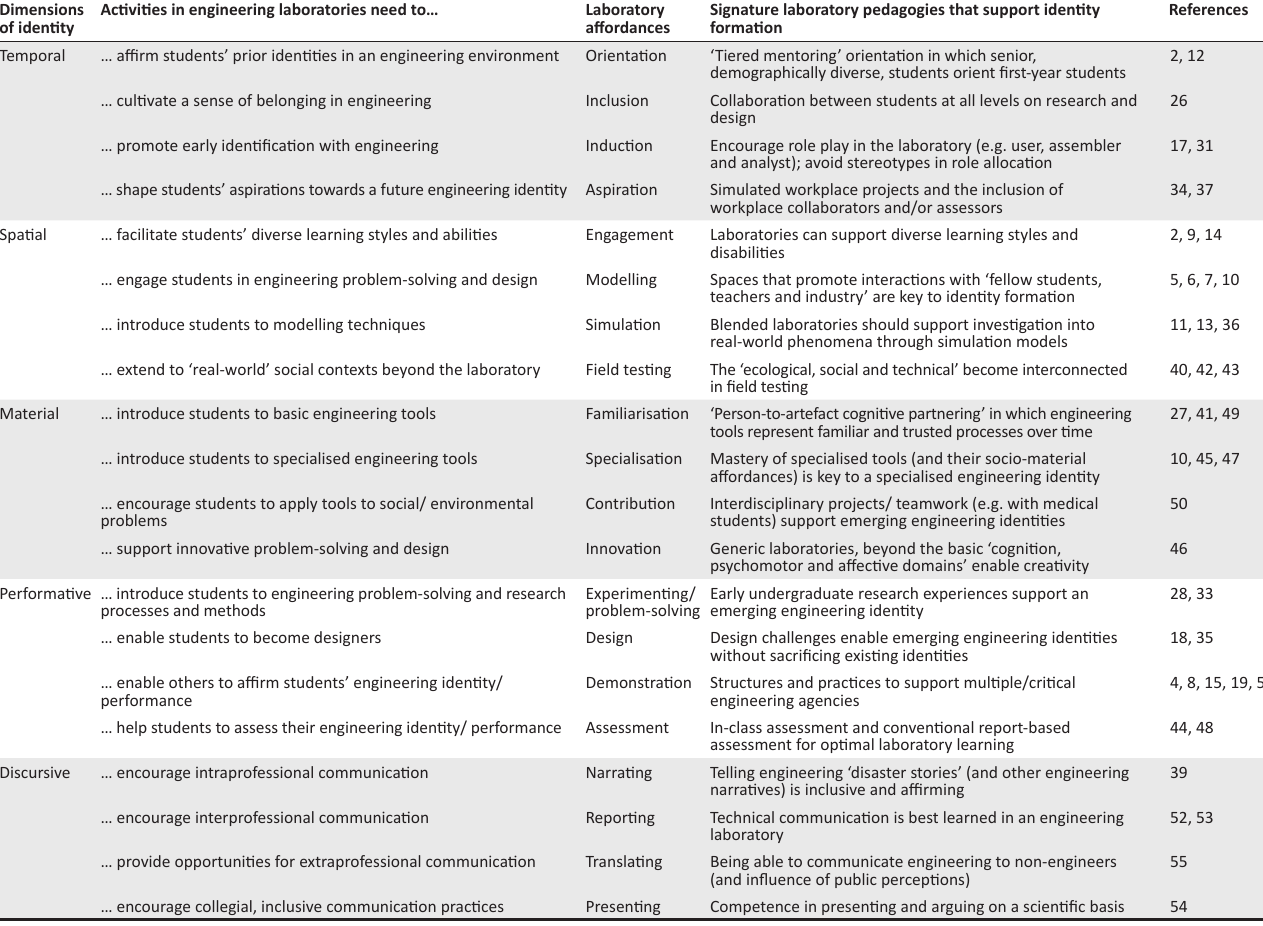
TABLE 2: Synthesis of results: The impact of laboratory spaces and practices on emergent engineering identities. Dimensions of